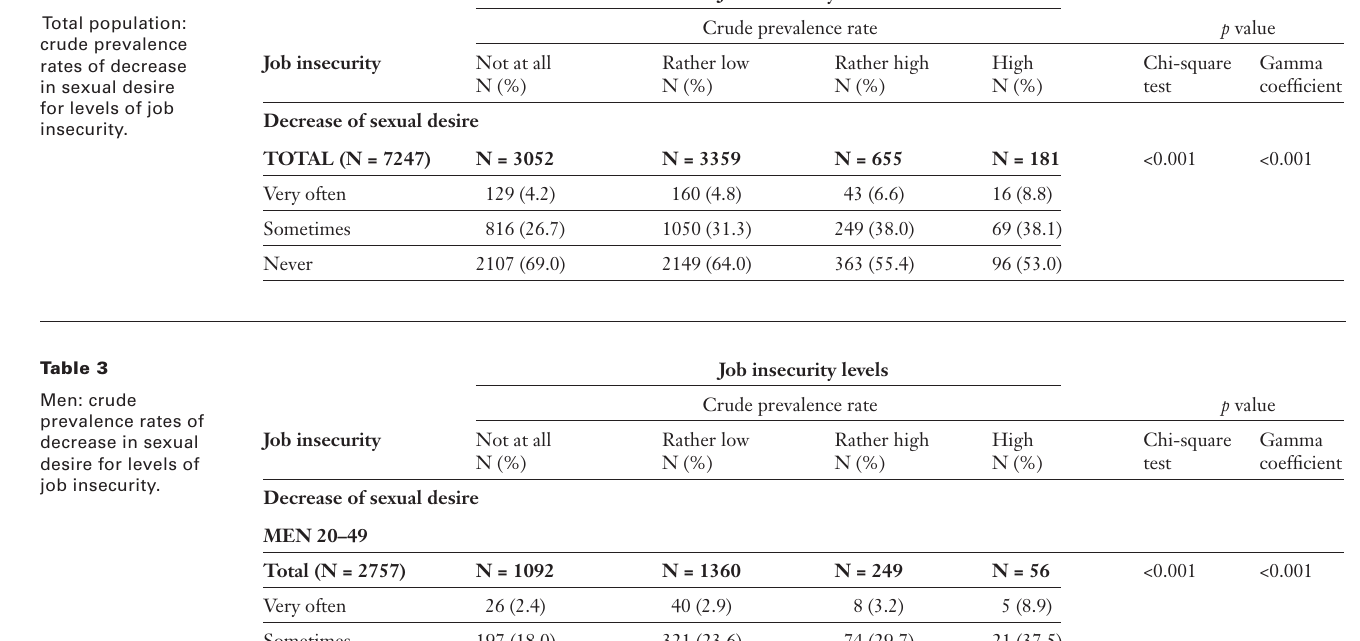
Total population: crude prevalence rates of decrease in sexual desire for levels of job insecurity.